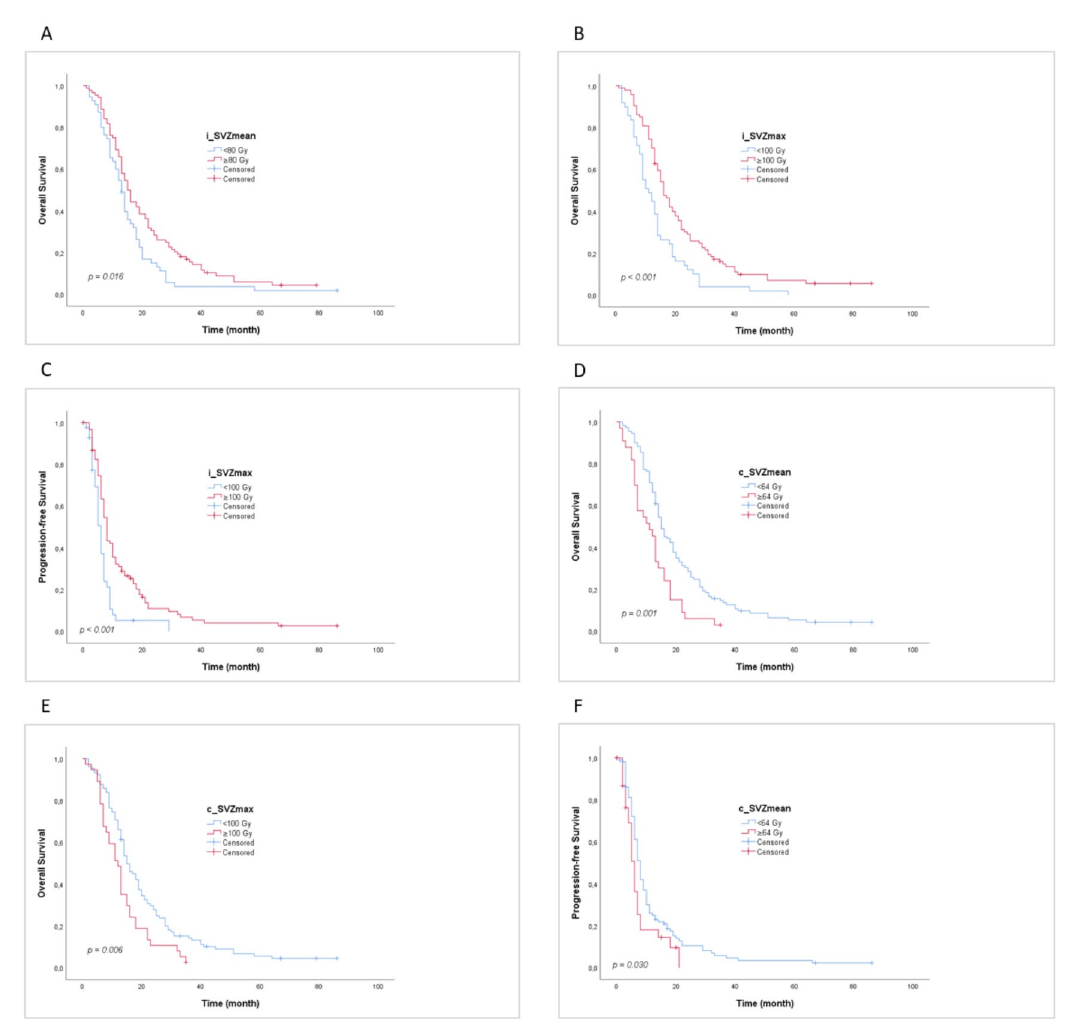
Figure 4. Kaplan–Meier estimates for progression-free survival (PFS) and overall survival (OS). ( A ) OS curve showing patient survival over time with respect to the mean ipsilateral subventricular zone (iSVZ) dose. ( B ) OS curve showing patient survival over time with respect to the max. iSVZ dose. ( C ) PFS curve showing patient survival over time with respect to the max iSVZ dose. ( D ) OS curve showing patient survival over time with respect to the mean contralateral subventricular zone (cSVZ) dose. ( E ) OS curve showing patient survival over time with respect to the max. cSVZ dose. ( F ) PFS curve showing patient survival over time with respect to the mean cSVZ dose.